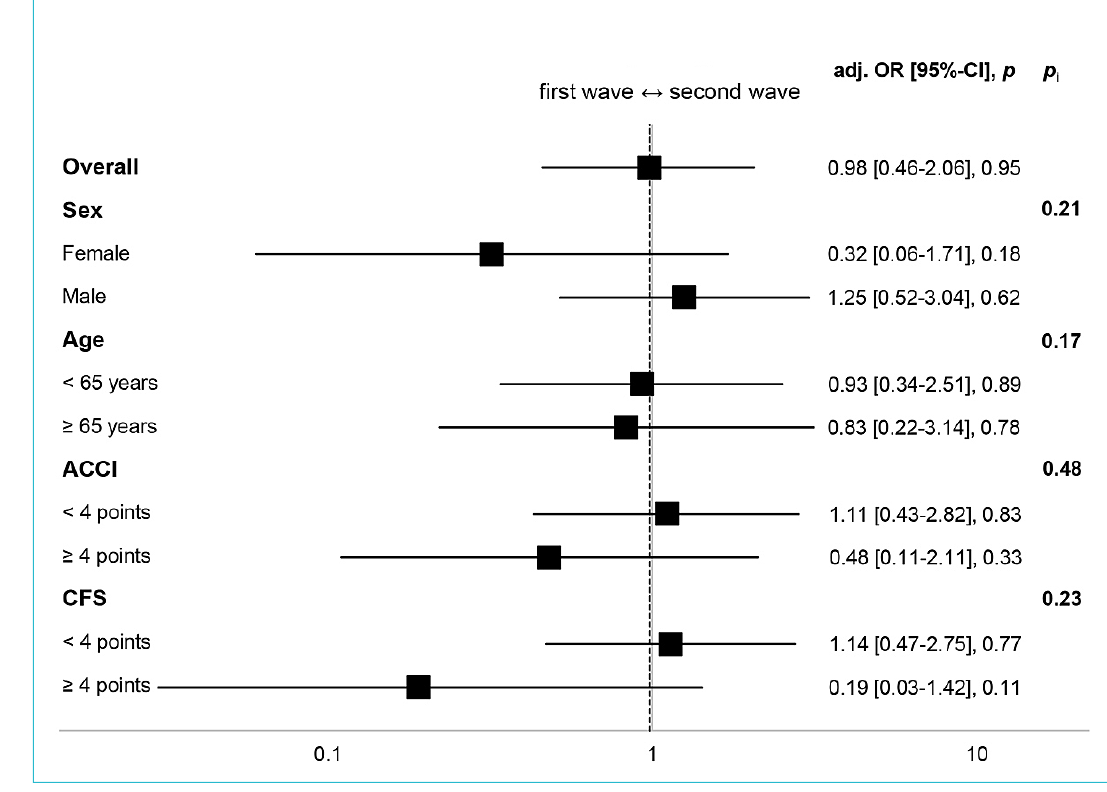
Figure 3: Subgroup analysis for ICU admission. Fully adjusted OR (Model 2) for wave (base = first wave). Higher ACCI/CFS scores indicate higher burden of comorbidity/frailty. Model 2 adjusted for sex, ACCI, CFS, immunomodulating home medication, time from symptom onset to admission, transfer from other